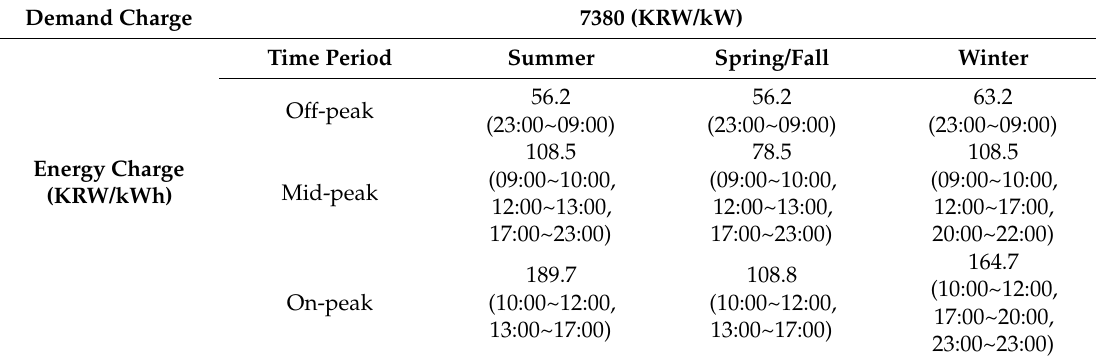
Table A3. TOU rate of Industrial (B), high-voltage (B), and Option-II by KEPCO [21]. Demand Charge